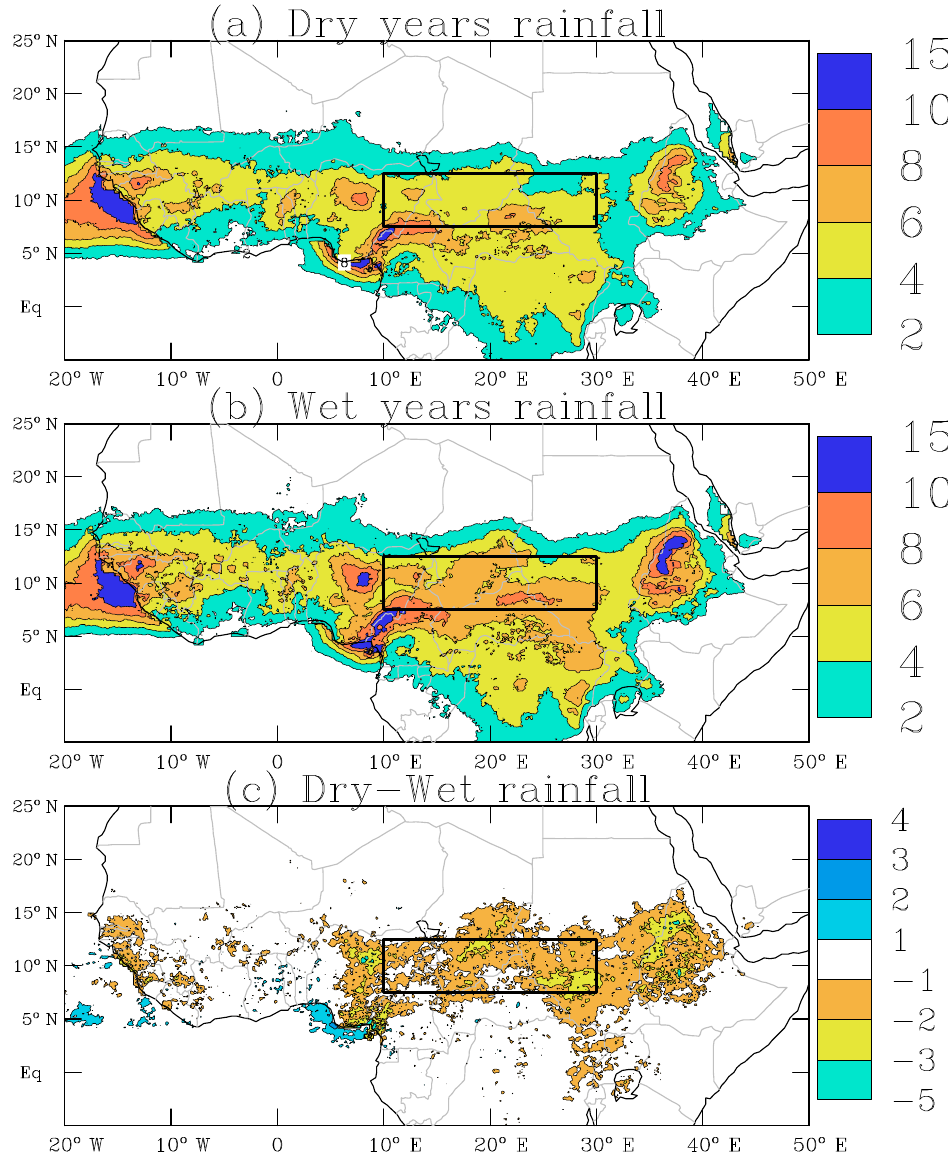
Figure 4. July to September average rainfall for ( a ) dry Central African years, ( b ) wet Central African years, and ( c ) difference between dry and wet years (dry–wet years). Unit in mm d − 1 .